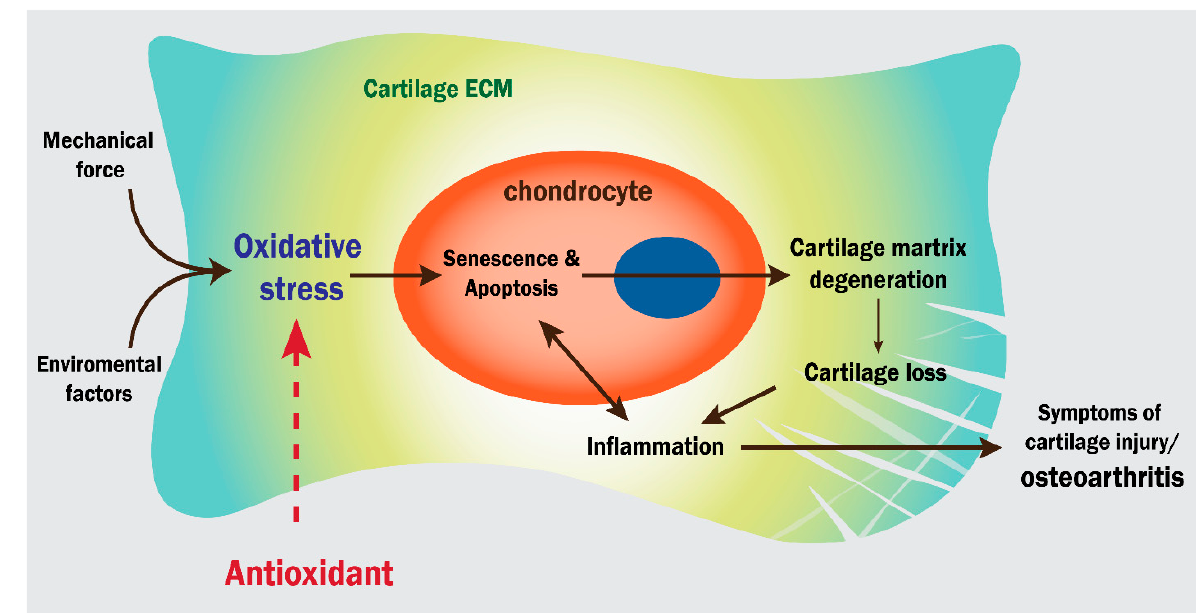
Figure 6. Illustration of oxidative stress’ role in cartilage degeneration and osteoarthritis. Antioxidants interfere with this pathway, as indicated by the red arrow.